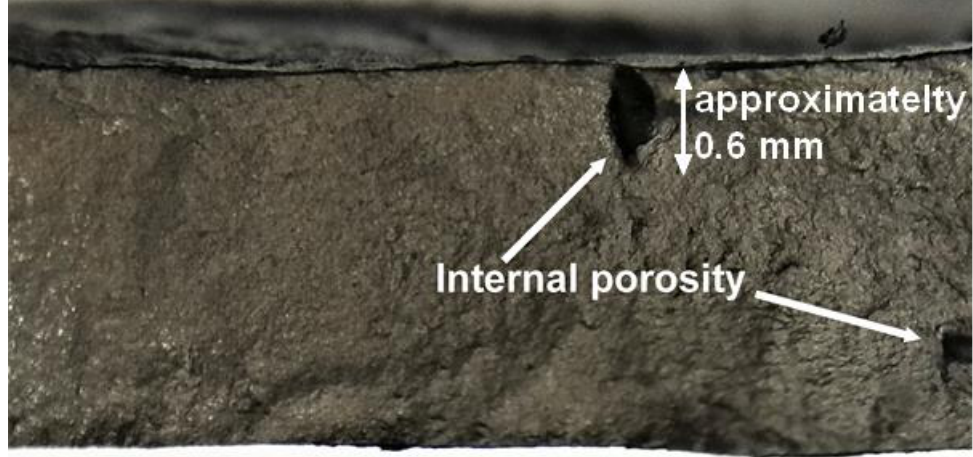
Figure 2. A close-up view of the failure surface shown in Figure 2 showing minimal crack growth associated with relatively large internal porosity/voids.